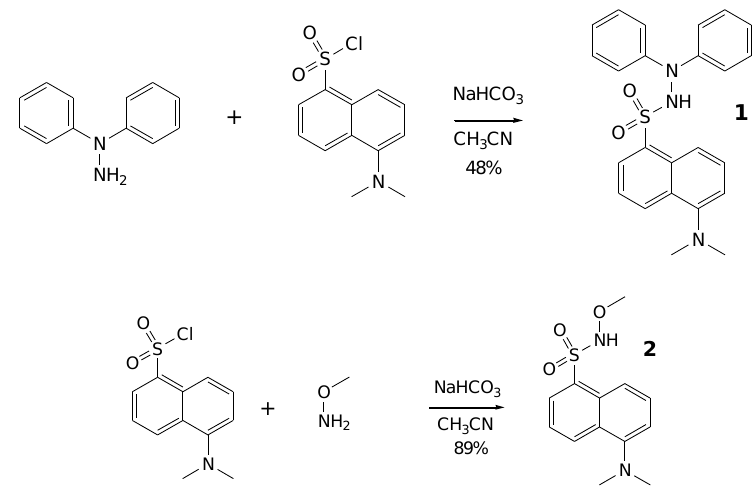
Figure 3. Synthesis of the compounds 1 and 2.